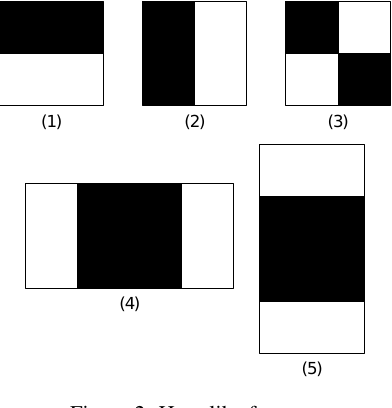
Figure 2: Haar-like